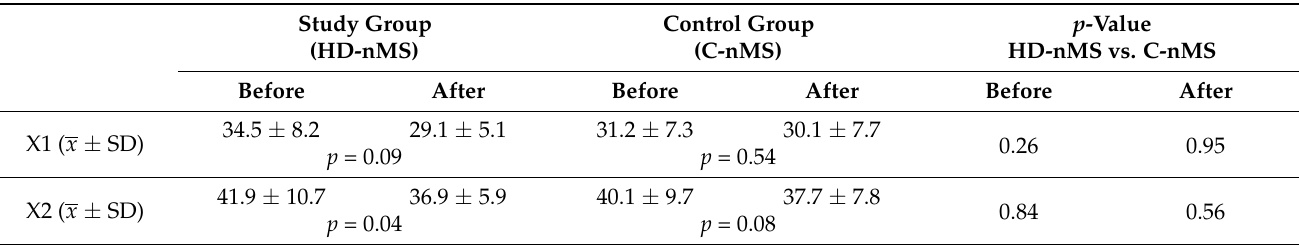
Table 5. Effect of rehabilitation program on the studied parameters in the study (HD) and control group (C) without metabolic syndrome